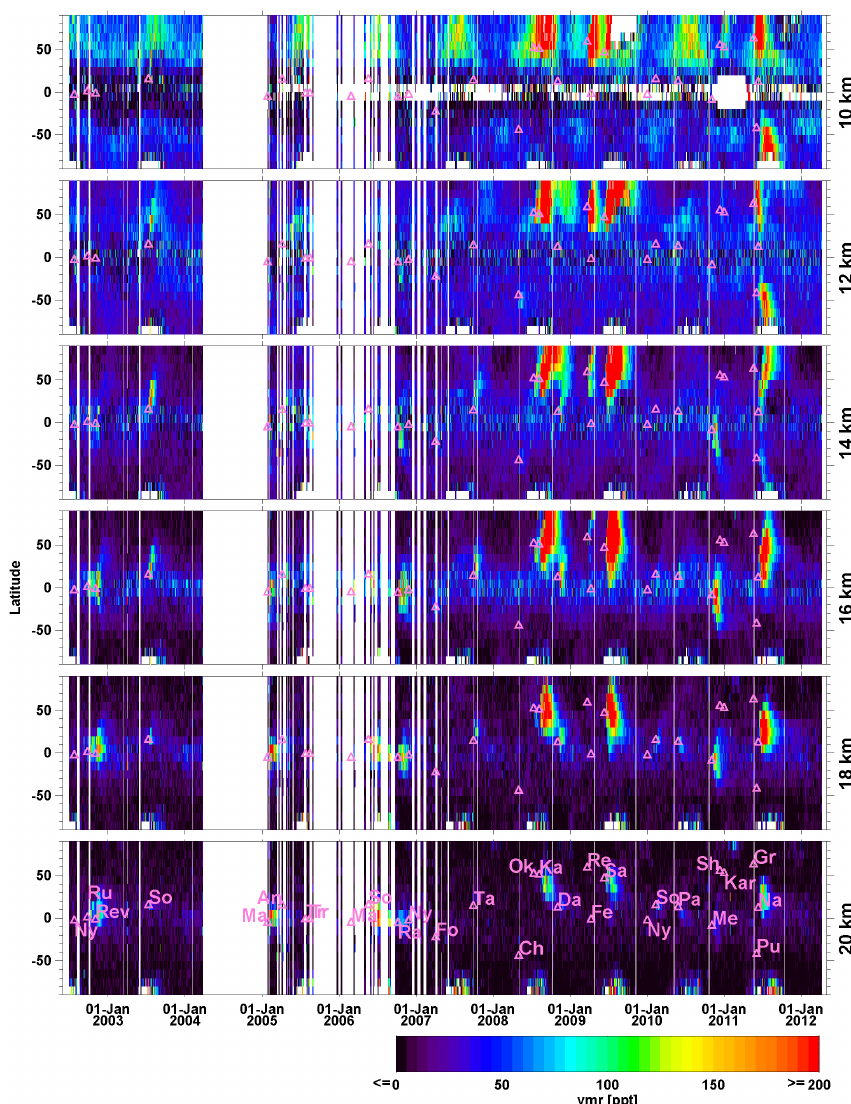
Figure 10. Global time series of colour-coded SO 2 distributions at various altitudes with a time resolution of 2 days. The colour scale is restricted to 0–200pptv: negative and values larger than 200pptv are given the colour belonging to 0 and 200pptv respectively. Volcanic eruptions are indicated at the latitude of their location (for details see Table